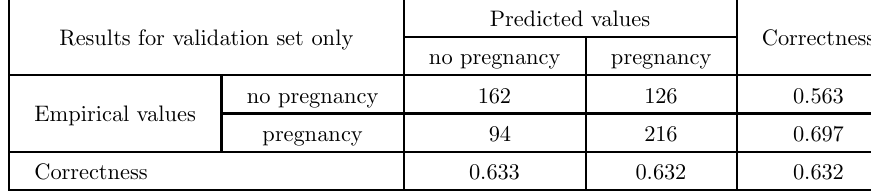
Table 6. Results for validation